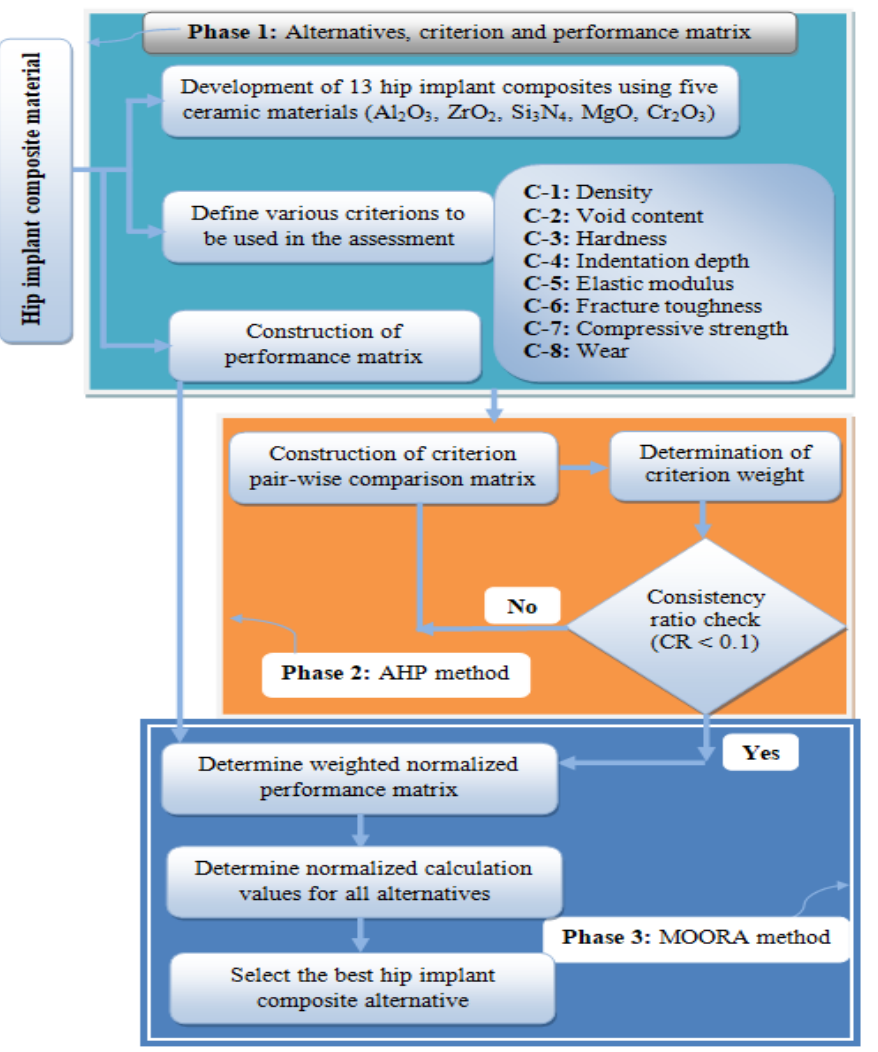
Figure 4. Architecture of the hybrid AHP-MOORA approach.